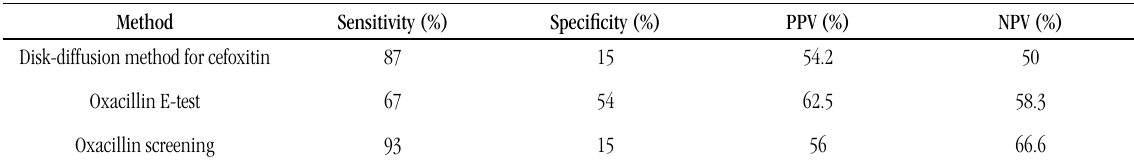
tABLE 2 – Validity test results (PCR is the gold standard) Disk-diffusion method for